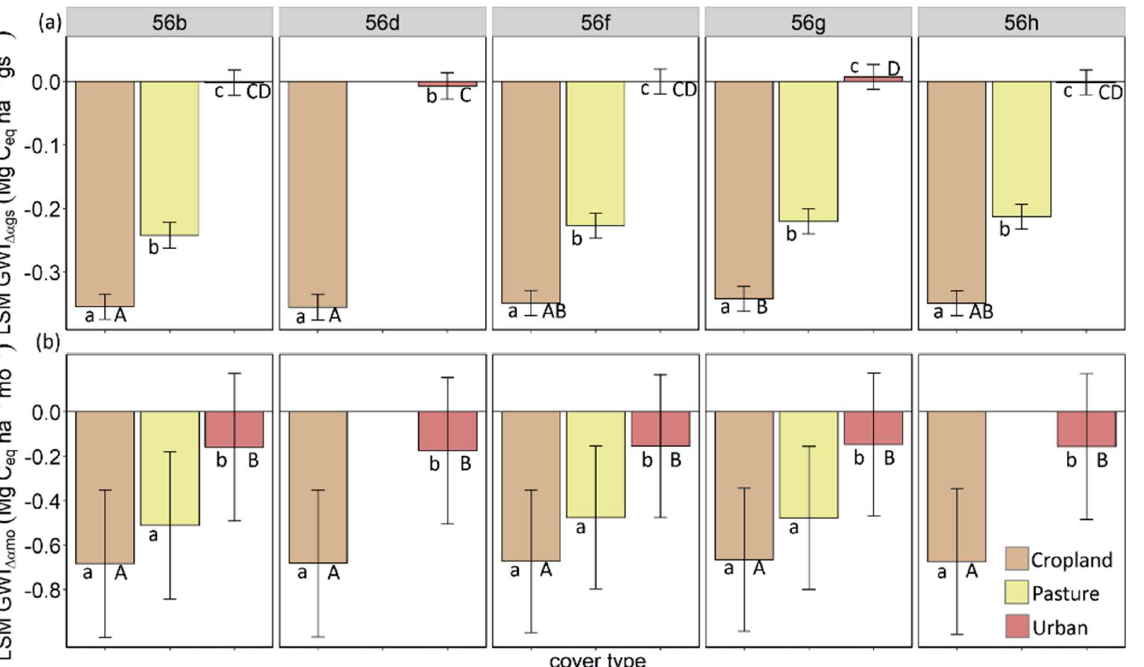
Figure 5. The least square means (LSMs) multi-comparison analysis of albedo-induced global warming impact (GWI ∆ α ) for a given cover type across the five Level IV ecoregions for the ( a ) growing season (GWI ∆ α gs ; 2001–2019) and ( b ) monthly (GWI ∆ α mo ; January–December) periods. Whiskers represent the lower and upper limits of the 95% family-wise confidence level of the LSMs. Bars sharing the same letters are not significantly different according to the post-hoc Tukey test analysis. Lowercase letters indicate differences among cover types within the five ecoregions, while uppercase letters indicate differences of same cover type among the five ecoregions. The among ecoregions analysis only considered cropland and urban covers (i.e., the cover types that were in every ecoregion). The overall GWI ∆ α contribution from different seasons and months varied by cover type, and it was exclusively higher during the non-growing season (NGS) than during the growing season (GS) months for all ecoregions (Table S6 and Figure 6), with the NGS months being characterized by only cooling effects (Table S7). As a general trend, the highest contributions were in February and the lowest in October. During the NGS, urban (at all ecoregions) contributed the most to the total cooling effect (between 18% and 31%), followed by pasture (at Ecoregions 56b, 56f, and 56g; contribution between 14% and 25%), and cropland (at all ecoregions; contribution between 14% and 24%). It is worth noting that during GS months, no cover type had a contribution >8% (i.e., 1/12 of the annual total). Nevertheless, climate regulations of urban (for all ecoregions) were close to the overall mean value of 8% in April, while cropland (at all ecoregions) and pasture (at Ecoregions 56b, 56f, and 56g) were close in April and